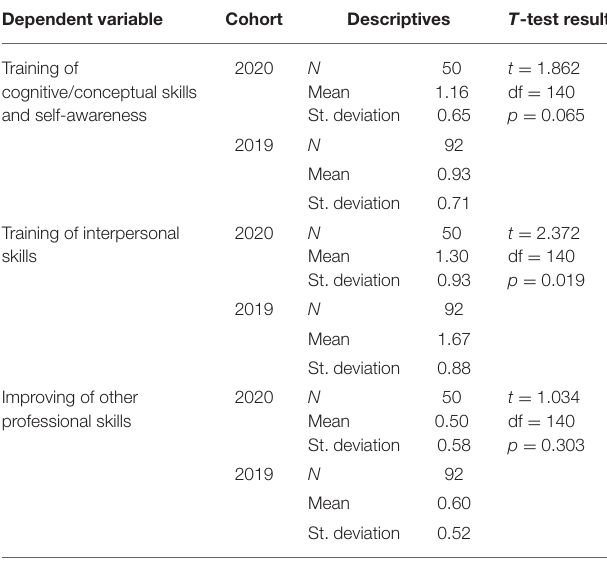
TABLE 2 | The t -test results reflecting the differences between the number of skills reported by students according to the year/learning environment and the category of skills.